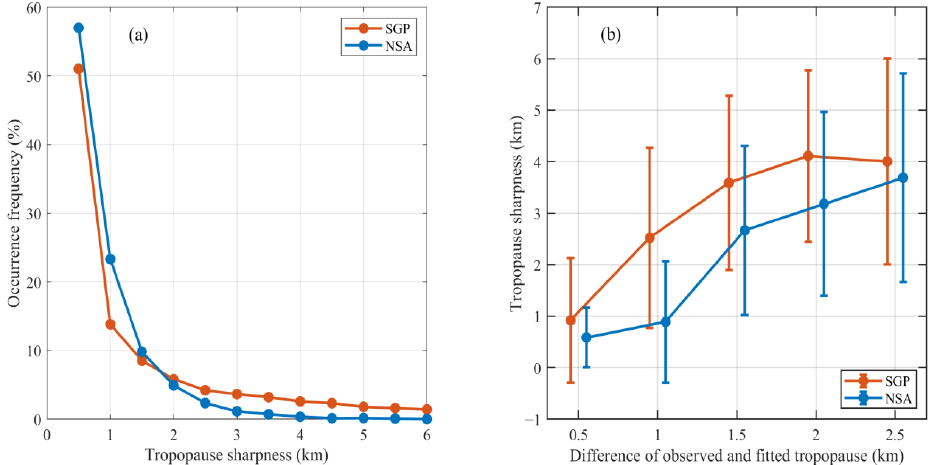
Figure 7. ( a ) Occurrence frequencies of the tropopause sharpness at SGP (brown line) and NSA (blue line). ( b ) Tropopause sharpness variations as a function of the absolute difference between the observed and fitted tropopause heights at SGP (brown line) and NSA (blue line).